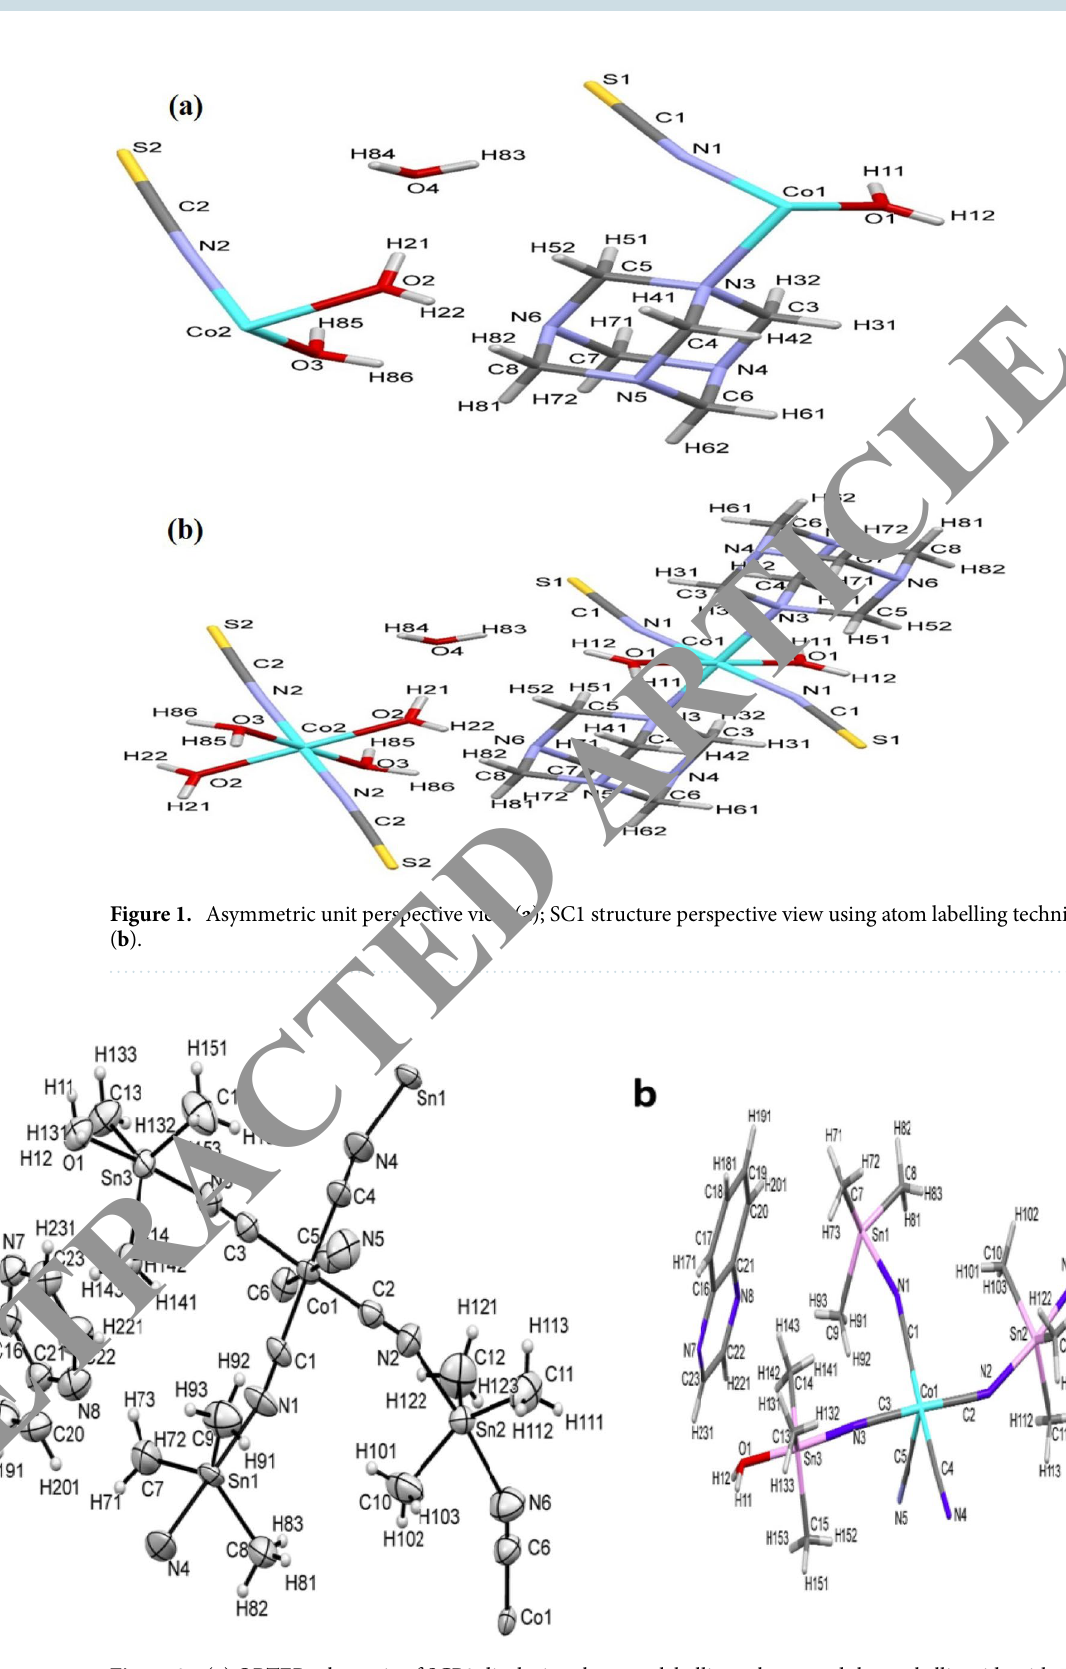
Figure 2. ( a ) ORTEP schematic of SCP2 displaying the atom labelling scheme and thermal ellipsoids with 50% probability ( b ) Perspective view of the SCP2’s asymmetric unit displaying the atom labelling